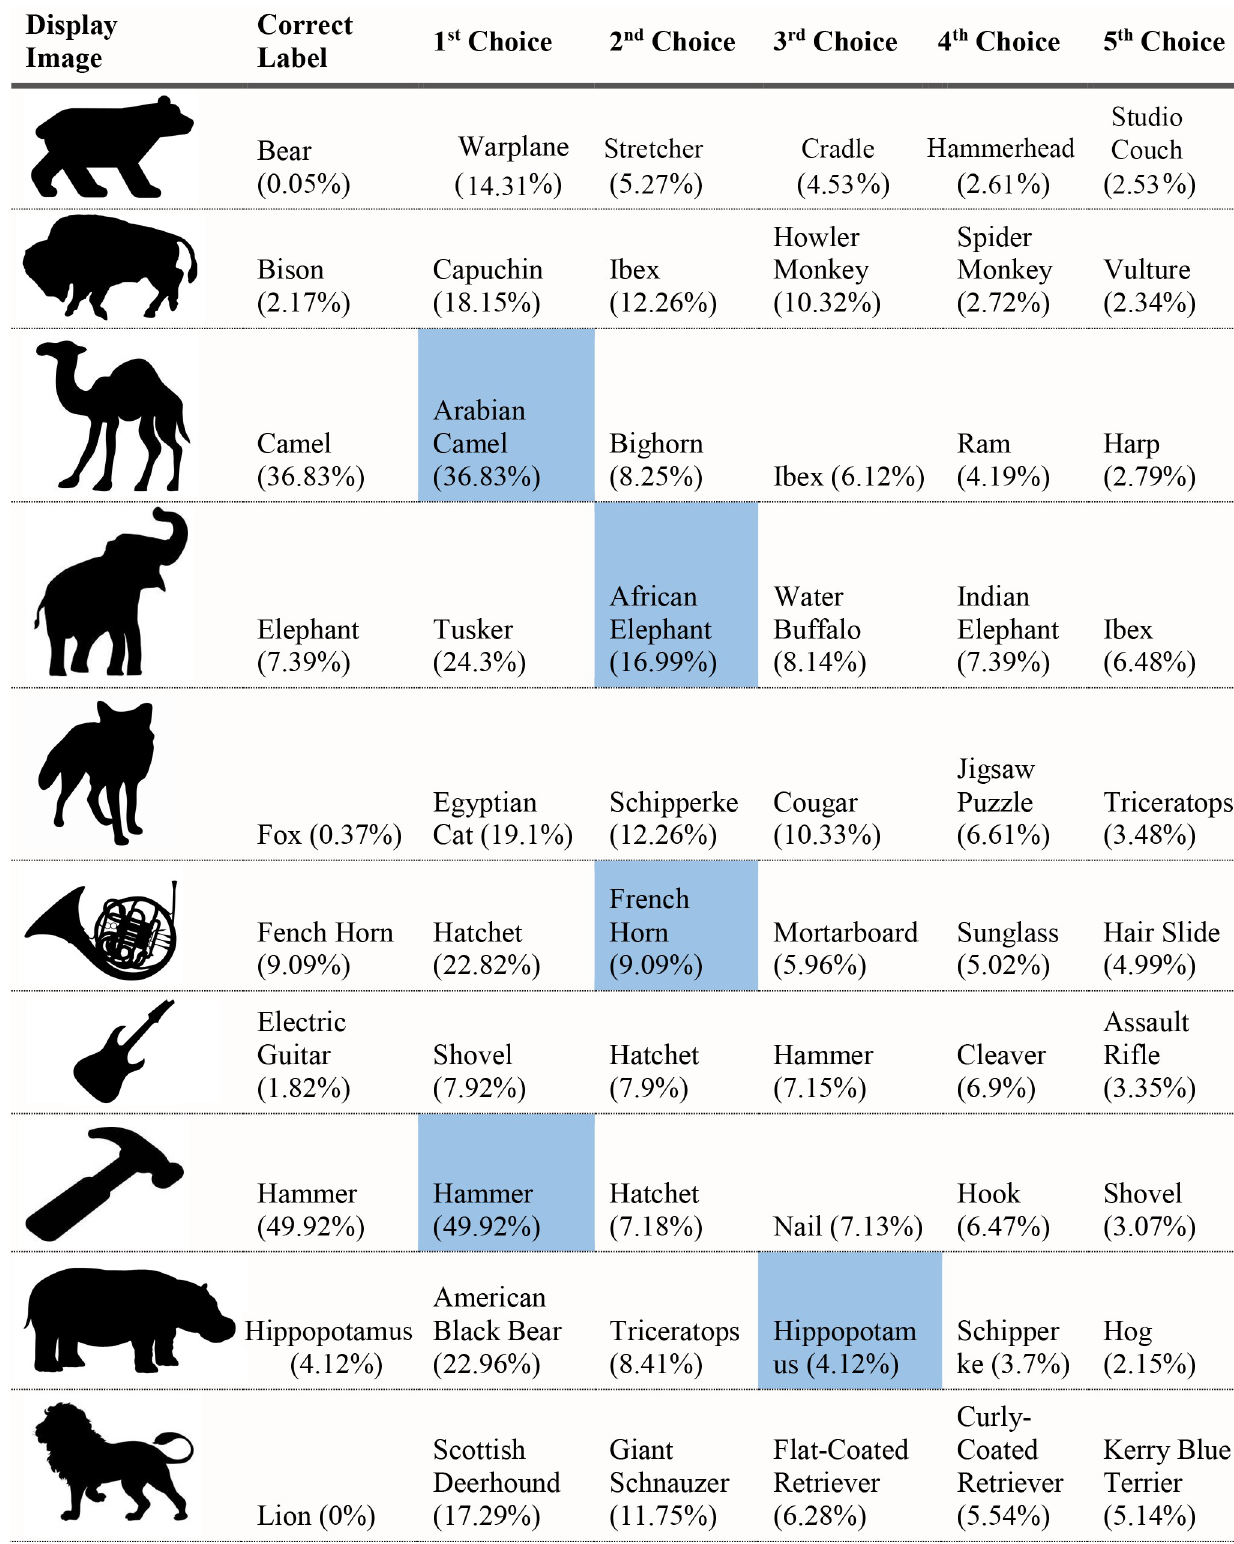
Fig 20. VGG-19 classifications for black object silhouettes Part 2.